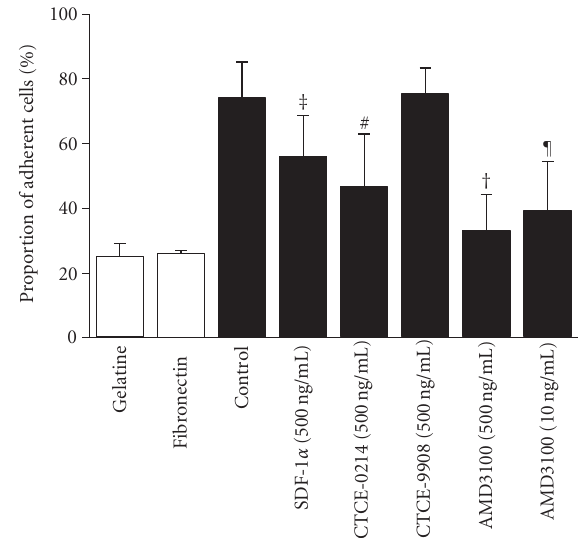
Figure 4: E ff ects on adhesion. Adhesion of CD34 + cells was either analyzed on protein-coated surfaces (white bars) or on mesenchy- mal stromal cells (MSCs) from human bone marrow (black bars) in culture media supplemented with SDF-1 α , CTCE-0214, CTCE- 9908, or AMD3100. Adhesion was significantly reduced by SDF-1 α , peptide agonist CTCE-0214, as well as by the mobilization agent AMD3100 (three independent experiments; ‡ P = . 014; # P = . 007; † P = . 7 × 10 − 4 ; ¶ P = . 002).